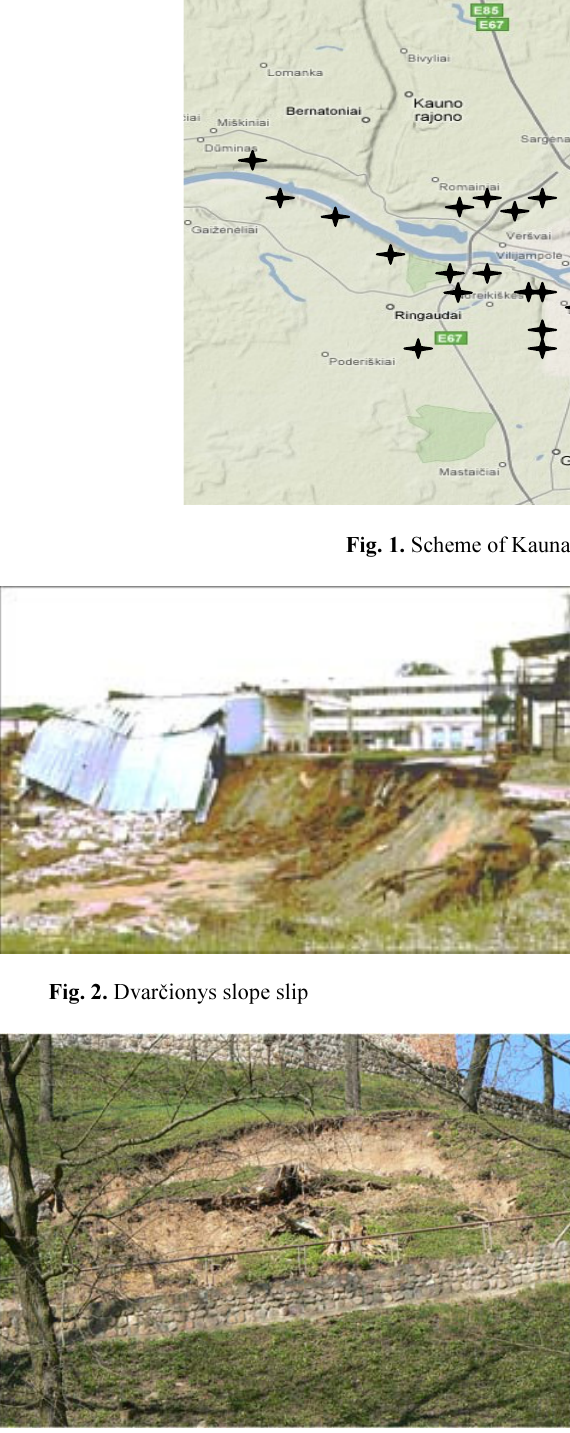
Fig. 3. Slip of the Gediminas mound slope (Photo by